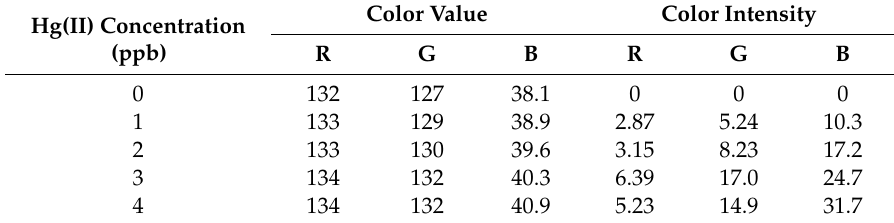
Figure 2. ( a ) Custom photo studio with 12 Volt LED lamps for appropriate lighting; ( b ) the result of the digital image at ppb-level mercury standards from 0 to 4 ppb; ( c ) the color change at the ppm level of mercury ion concentration from 0 to 150 ppm. The volume of the sample in each cuvette was 1 mL.